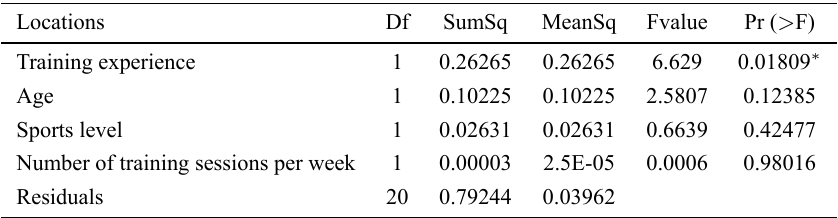
Table 1. ANOVA effect of training experience, age of players, level of sport and the number of week micro cycle training on the presence of weak links in low threshold tests.